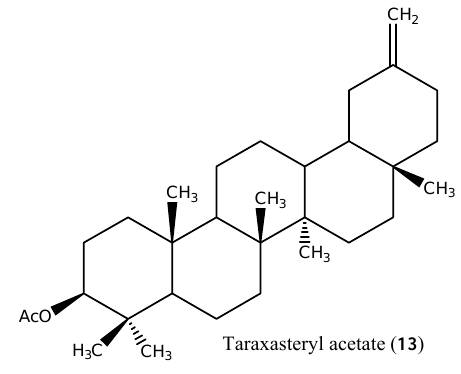
Figure 3. Bioactive terpenoids from I. britannica .